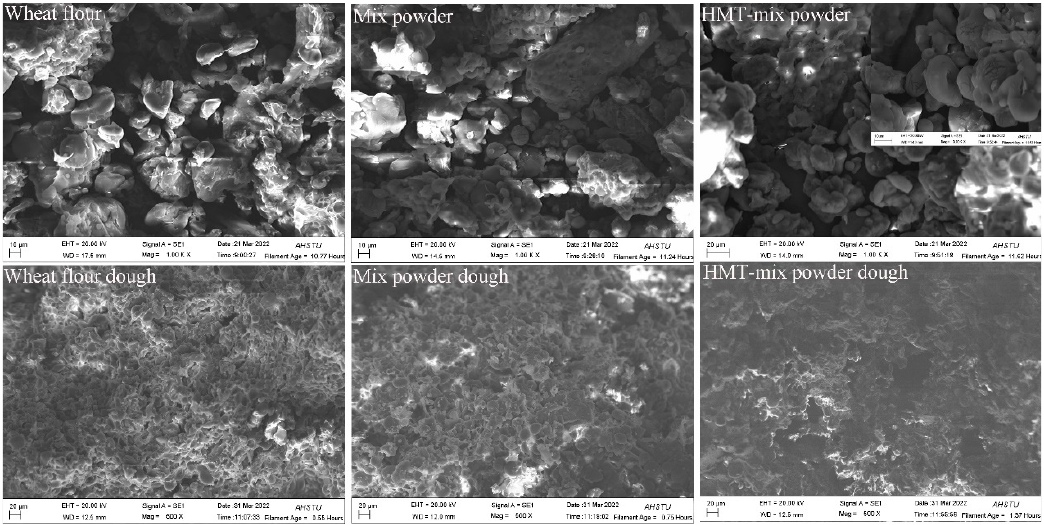
Figure 3. SEM images of wheat four, mix powder, HMT-mix powder and their dough.